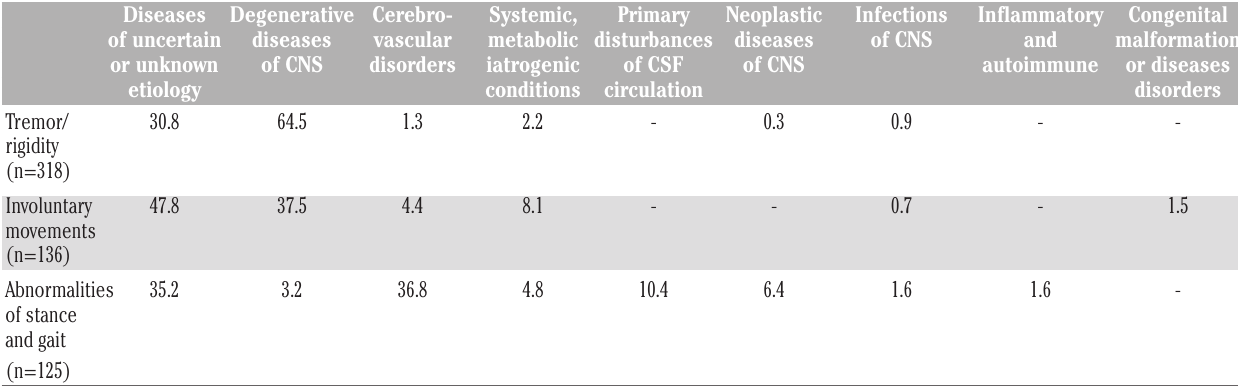
Table 2. Percentage of patients included in the different categories of neurological diseases according to type of movement disorder. Diseases Degenerative